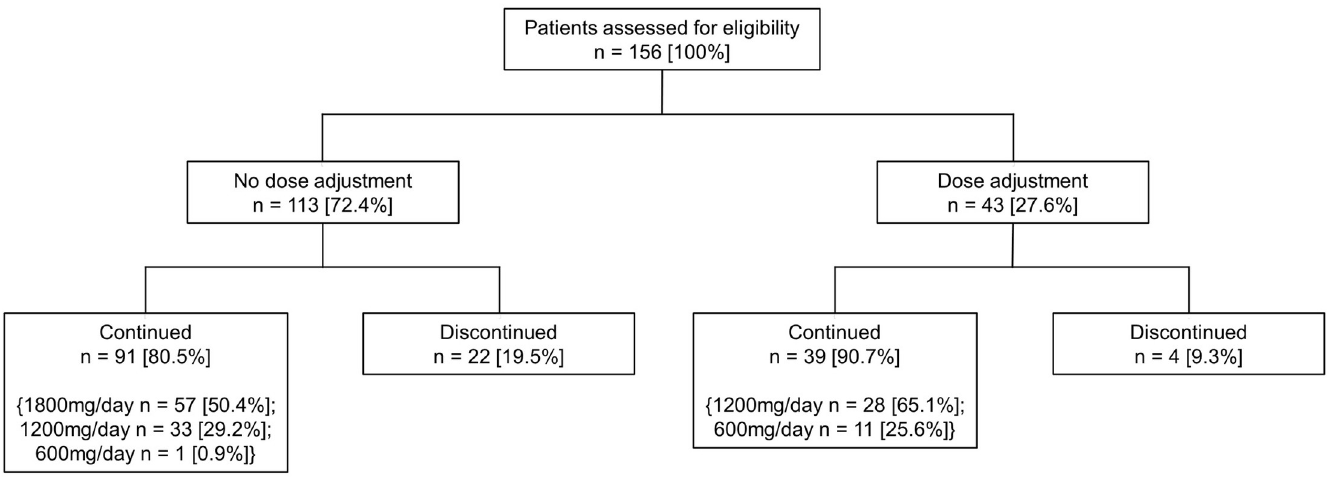
Fig 1. Patient disposition.